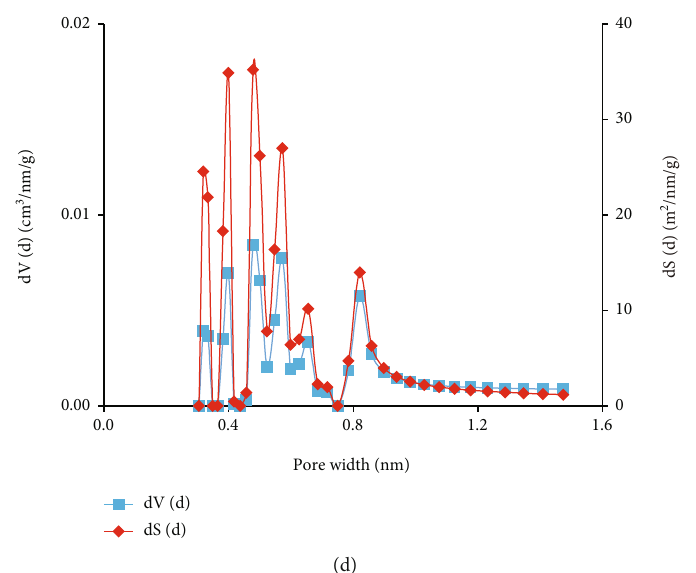
Figure 4: Typical sample CO adsorption isotherms and pore size distribution of 2